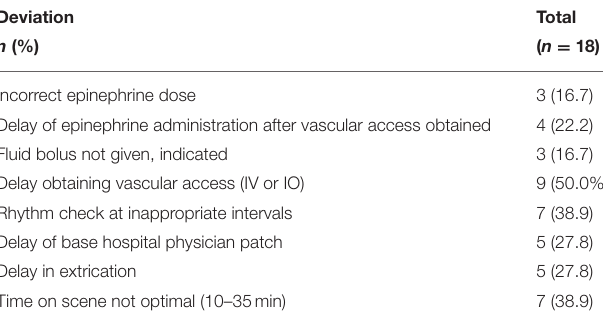
TABLE 4 | Deviations in positive prognostic scored patients. Deviation Total n (%) ( n = 18) Incorrect epinephrine dose 3 (16.7) Delay of epinephrine administration after vascular access